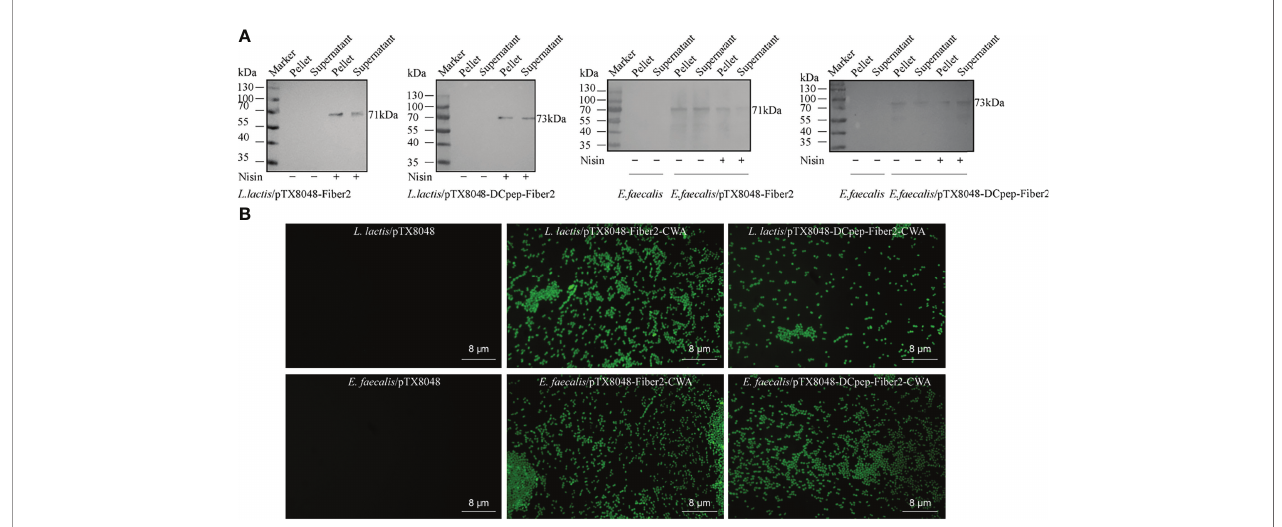
FIGURE 3 | Detection of Fiber2 protein expressed on the surface of probiotics. ( A ) Western blot detection of Fiber2 protein expression on the surface of probiotics L. lactis and E. faecalis induced with 5 ng/ml nisin using rabbit anti-Fiber2 polyclonal antisera as primary antibody. (B) Indirect immuno fl uorescence detection of Fiber2 protein displayed on the surface of bacteria using rabbit anti-Fiber2 polyclonal antisera as primary antibody and FITC-conjugated goat anti-rabbit IgG as the secondary